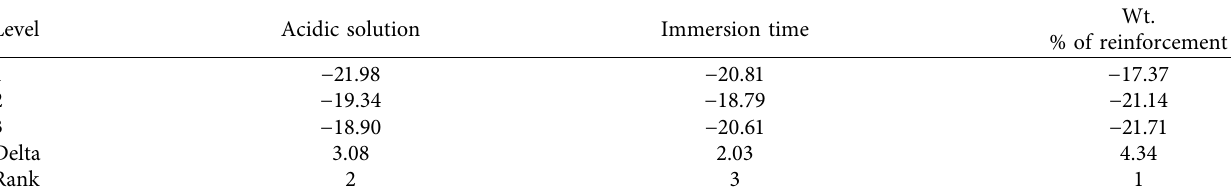
Table 4: Response table for corrosion rate.